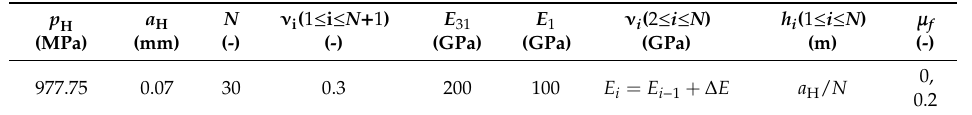
Table 2. Input parameters of the present method for simulating a half ‐ space coated with 30 layers subjected to the surface point contact loading. Note: